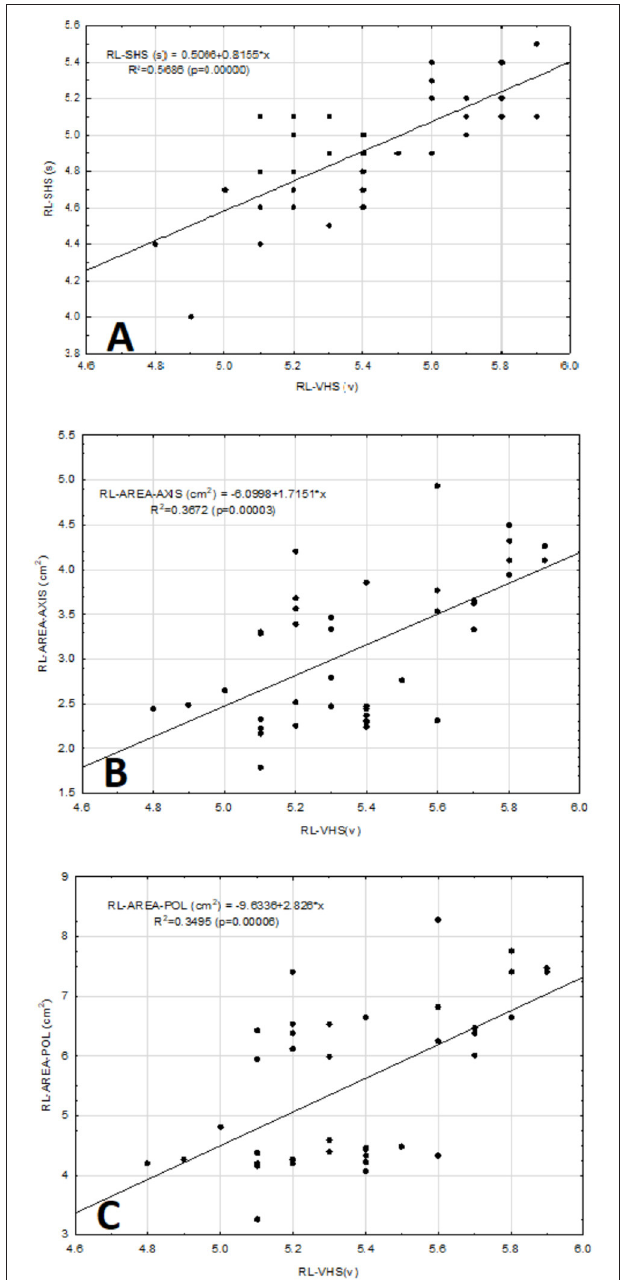
FIGURE 5 | Scatter diagram between vertebral heart scale [VHS (v)] vs. sternebral heart scale [SHS (s)], axis cardiac area [AREA-AXIS (cm 2 )], and open polygon cardiac area [AREA-POL (cm 2 )] in the right lateral projection (RL) obtained from 40 clinically normal ferrets (A–C) . The straight line represents the linear equation adjusted to the data points. The corresponding equation is provided in each panel.